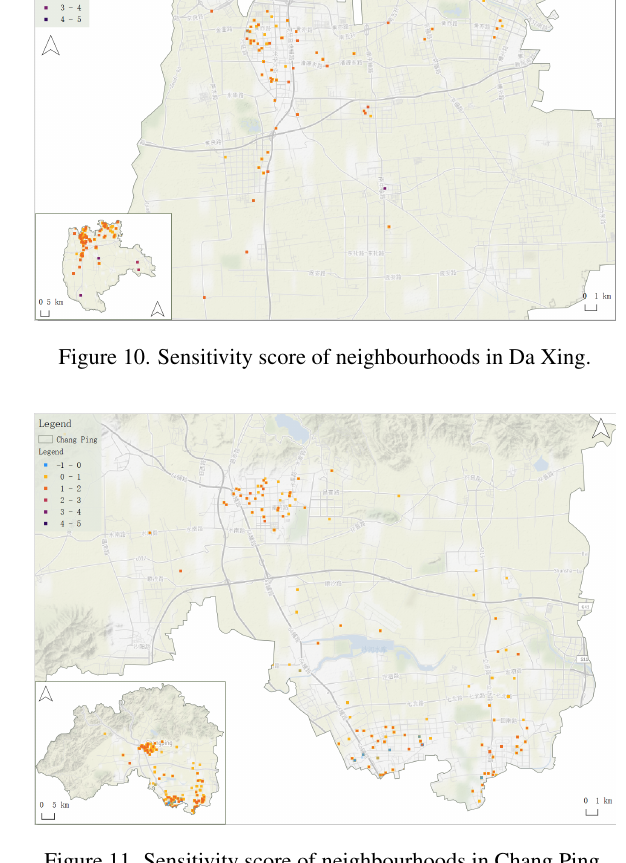
Figure 9. Sensitivity score of neighbourhoods in the study area in Beijing.